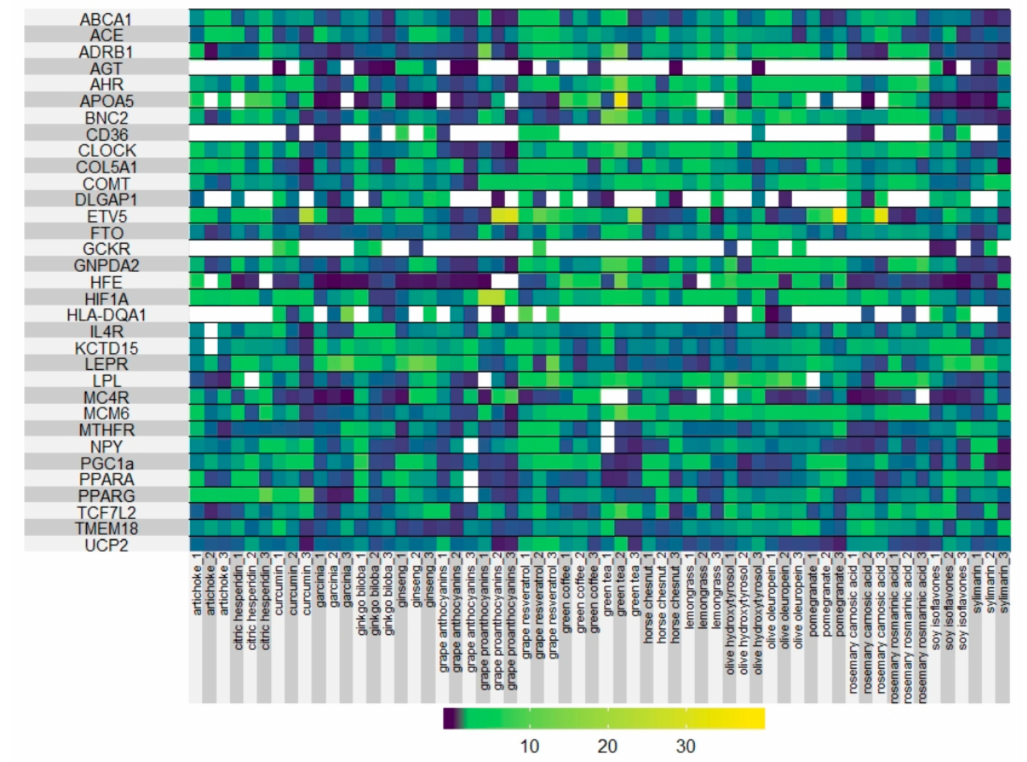
Figure 2. Heat map representation of the effects of the extracts (3 doses) on gene expression.